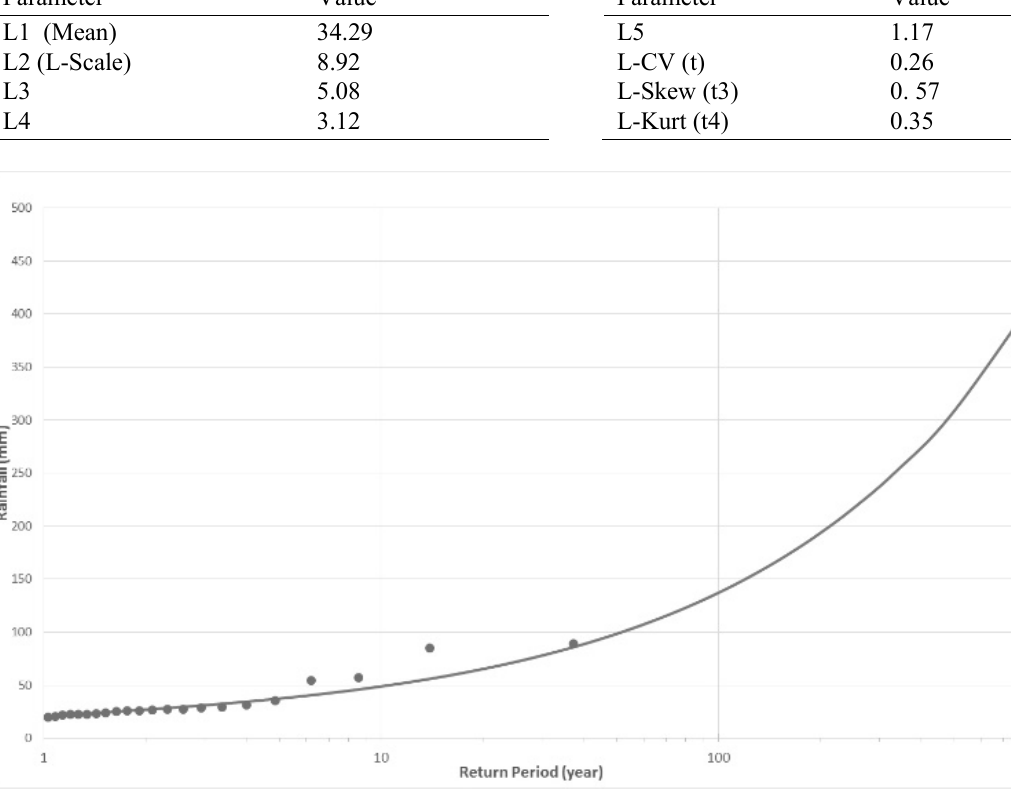
Fig. 2 Rainfall frequency